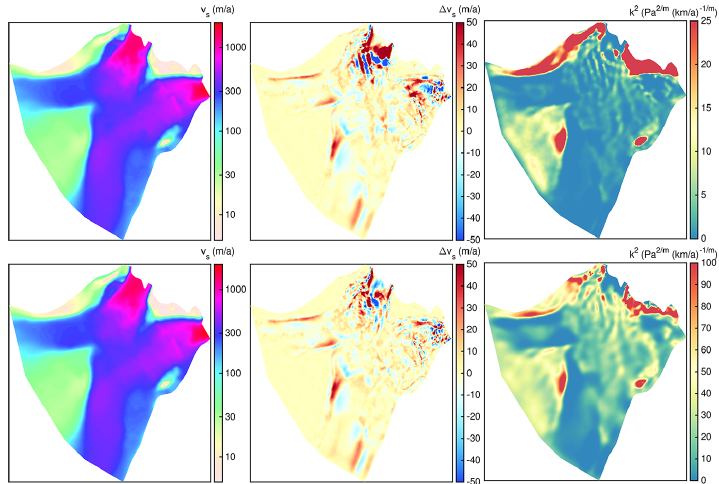
Figure A2. Overview of the ISSM inversion performed with the different values for m = 1 and m = 3 at the outlet region. The upper row shows simulated surface velocities (a) , velocity difference between observed and simulated velocities (b) , and the inferred basal friction coefficient k 2 (c) for m = 1. The lower row shows the equivalent fields for m = 3.